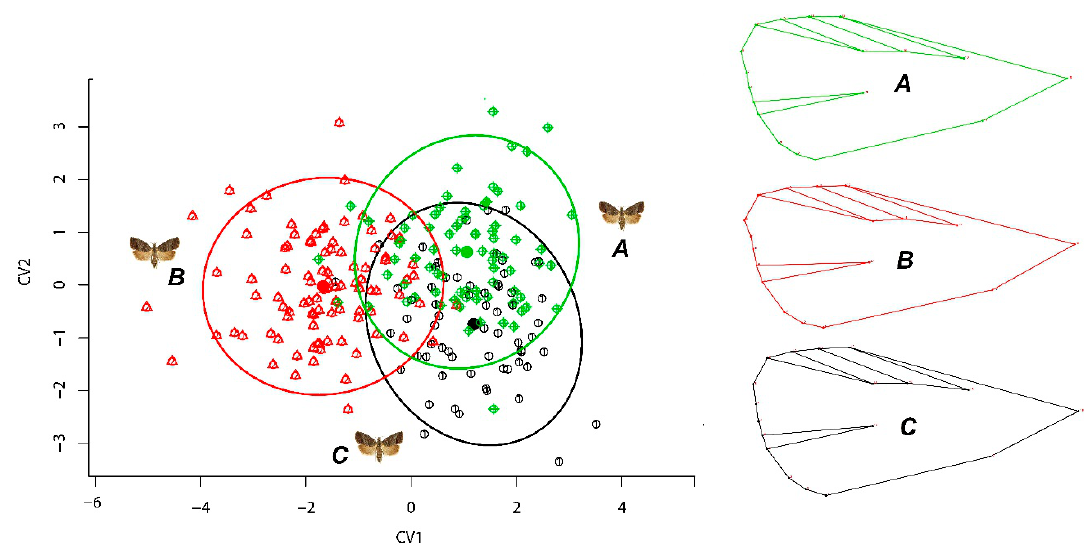
Figure 4. Canonical variate analysis (CVA) visualization of forewing shape differences for codling moth: ecological (green, A); laboratory-reared (red, B); integrated (black, C).